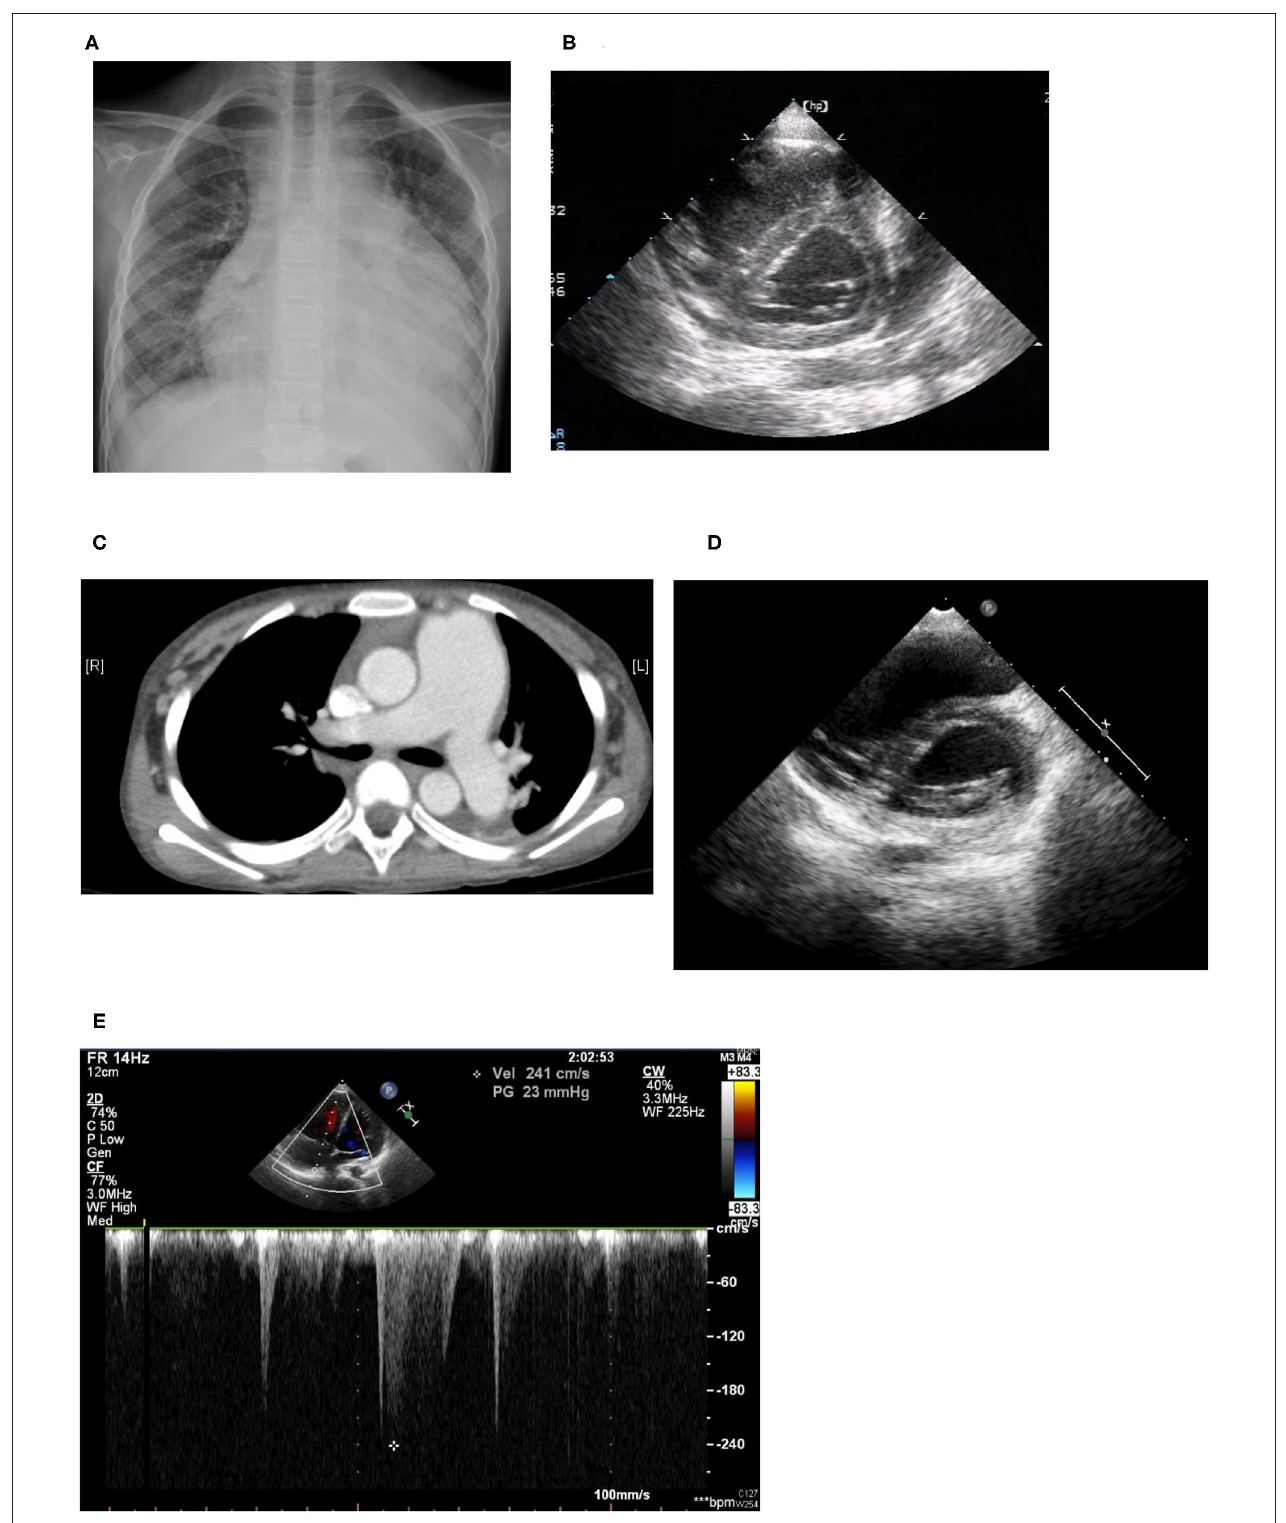
FIGURE 2 | (A) Cardiomegaly and pleural effusion seen on chest x-ray on admission. (B) Echocardiogram on admission: Right ventricle dilatation due to pulmonary hypertension with shift of the intraventricular septum to the left, resulting in a D-shaped left ventricle (D-sign). (C) Chest CT: Dilated pulmonary arteries. (D) Echocardiogram performed 1 year later: improving pulmonary hypertension with resolution of “D-sign.” (E) Echocardiogram performed 1 year later: Improving pulmonary hypertension with tricuspid regurgitation with maximum velocity of 2.41 m/s, estimated right ventricle systolic pressure 30 mmHg.